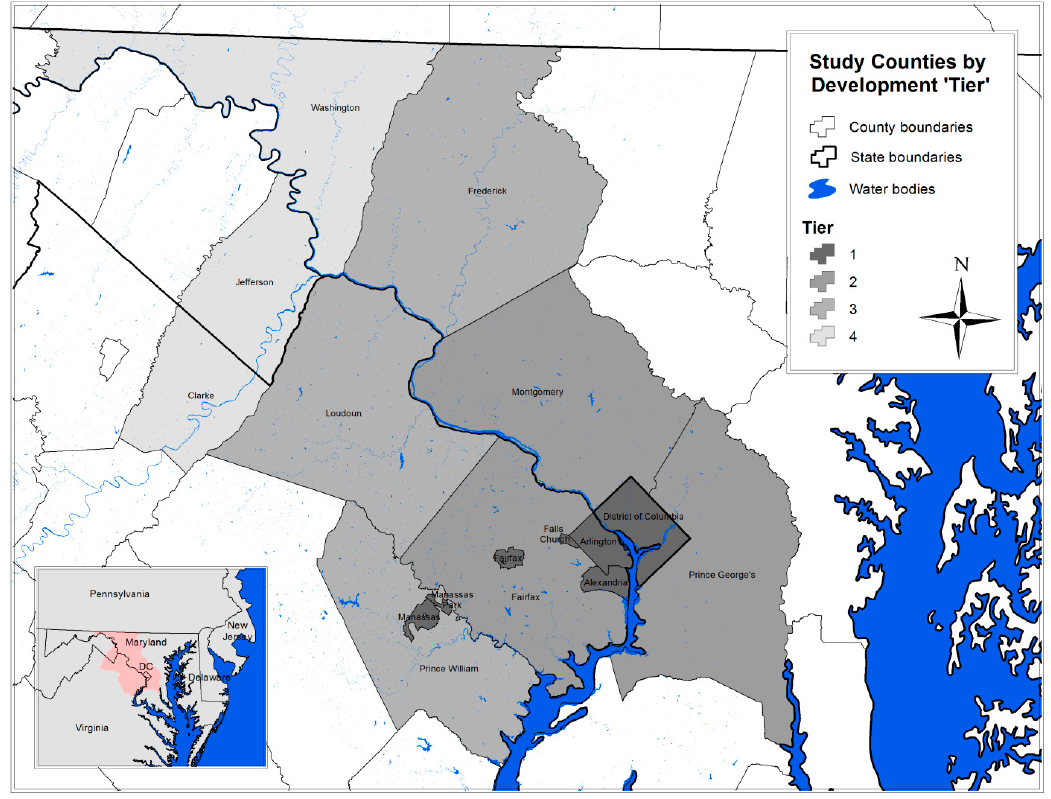
Figure 2. The sixteen study counties and independent cities colored by development “tier”, as determined by the total amount of impervious cover, and relative distance from the Washington, DC, urban center.